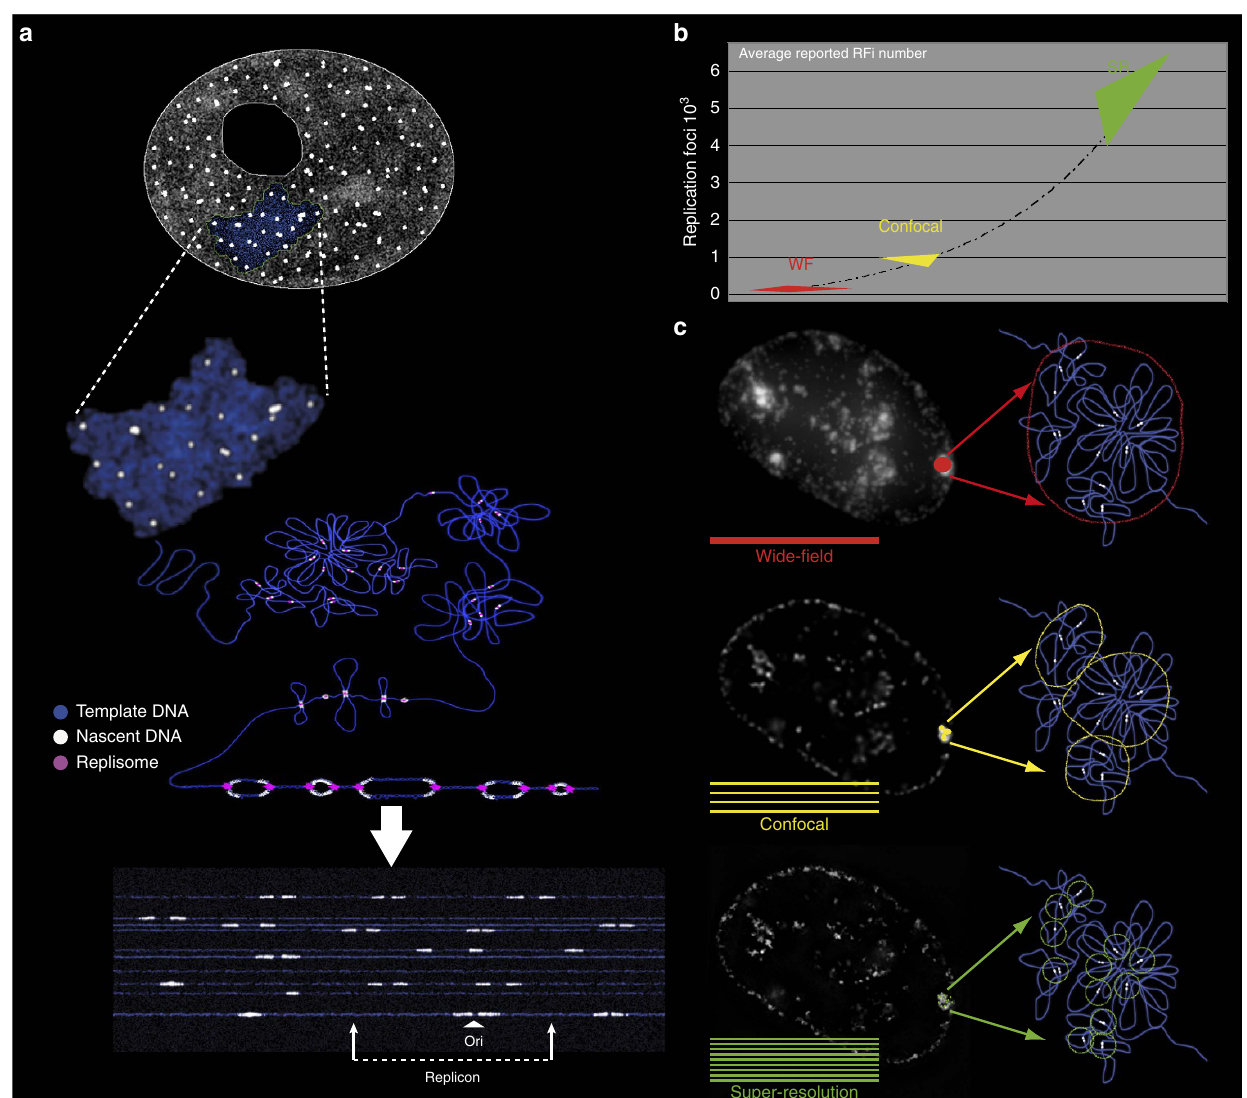
Figure 4 | Replication sites dissected by super-resolution microscopy in the mammalian nucleus correspond to individual replicons. ( a ) A cartoon showing how replication sites/units can be seen at different levels of chromatin compaction from the extended DNA fibres to the 3D-preserved whole-cell (nucleus) level. ( b ) Increase in RFi numbers driven by resolution improvements in microscopy during the past three decades 42 . WF: wide field; SR: super- resolution microscopy. ( c ) Microscopic images and corresponding cartoon interpretation of replication sites in the mammalian nucleus imaged at different levels of resolution. For summary of experimental numbers and calculations see Table 0.77 has a MSE of 0.3 respectively. Those MSE take into account the variances of the measured genome size (Table 2), the measured fork speed (Table 3) and the measured S-phase length (Table 1). The difference of the average number of replicons per single RF between human (0.92) and mouse (0.77) cells, likely arise from differential clustering of replication forks in particular cell types and/or S-phase sub-periods when some RFi can contain individual replication forks.